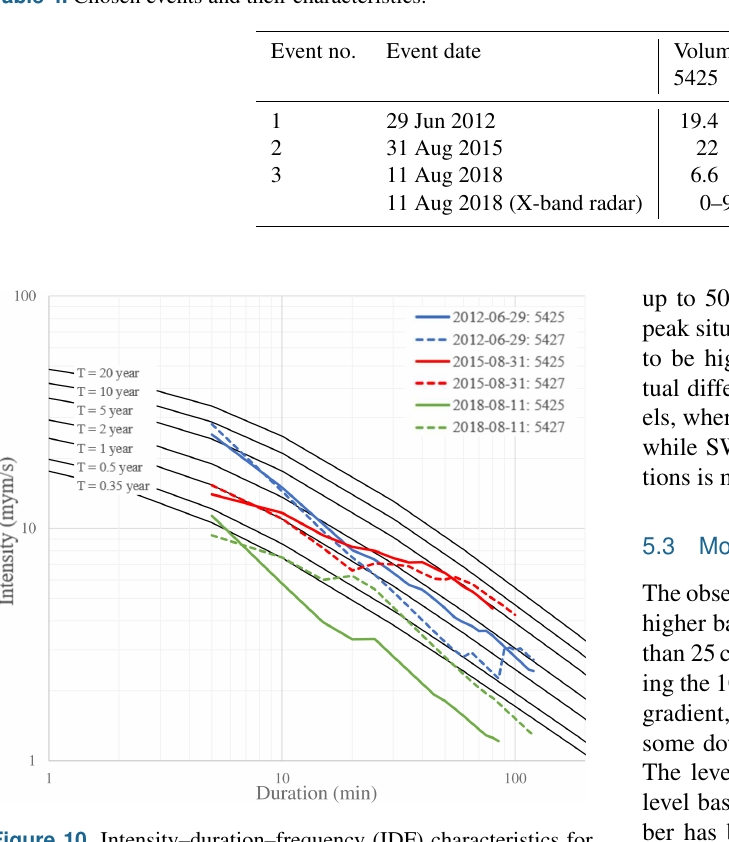
Figure 10. Intensity–duration–frequency (IDF) characteristics for the three selected rain events (2012, 2015 and 2018) measured at two different rain gauges (gauge 5425 and 5427), plotted on top of national regional IDF curves for Odense (Gregersen et al., 2014). T indicates return periods, corresponding to the reciprocal of the